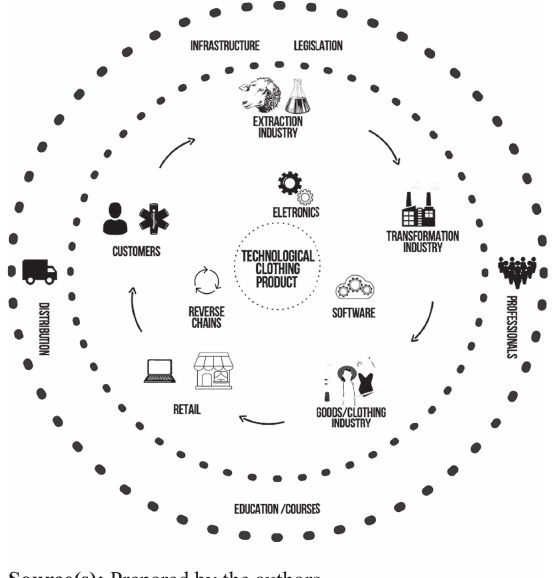
Figure 2. Conceptual model of fashion value